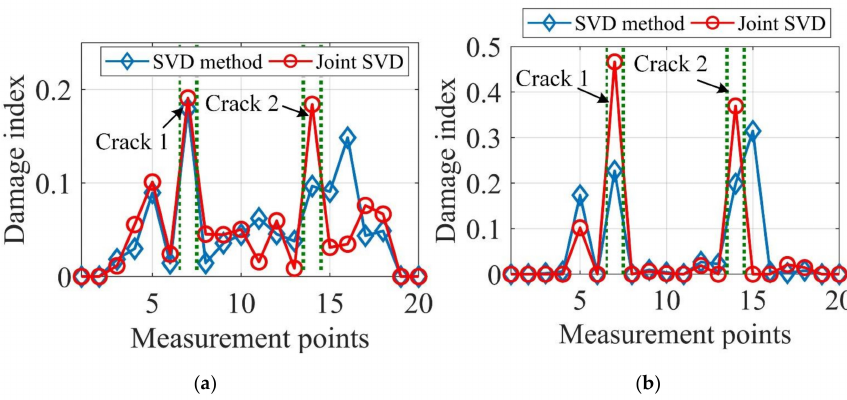
Figure 4. Damage localization results of two cracks with 5% depth reduction. ( a ) Proposed data fusion approach; ( b ) Bayesian fusion.